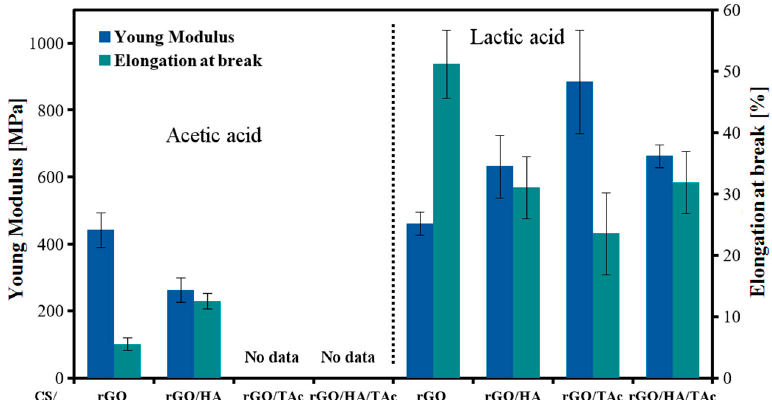
Figure5. Young’smodulusandelongationatbreakofCSnanocomposites(CS—chitosan, rGO—reduced Figure 5. Young’s modulus and elongation at break of CS nanocomposites (CS—chitosan, rGO— graphene oxide, HA—hydroxyapatite, TAc—tannic reduced graphene oxide, HA—hydroxyapatite, TAc—tannic acid).